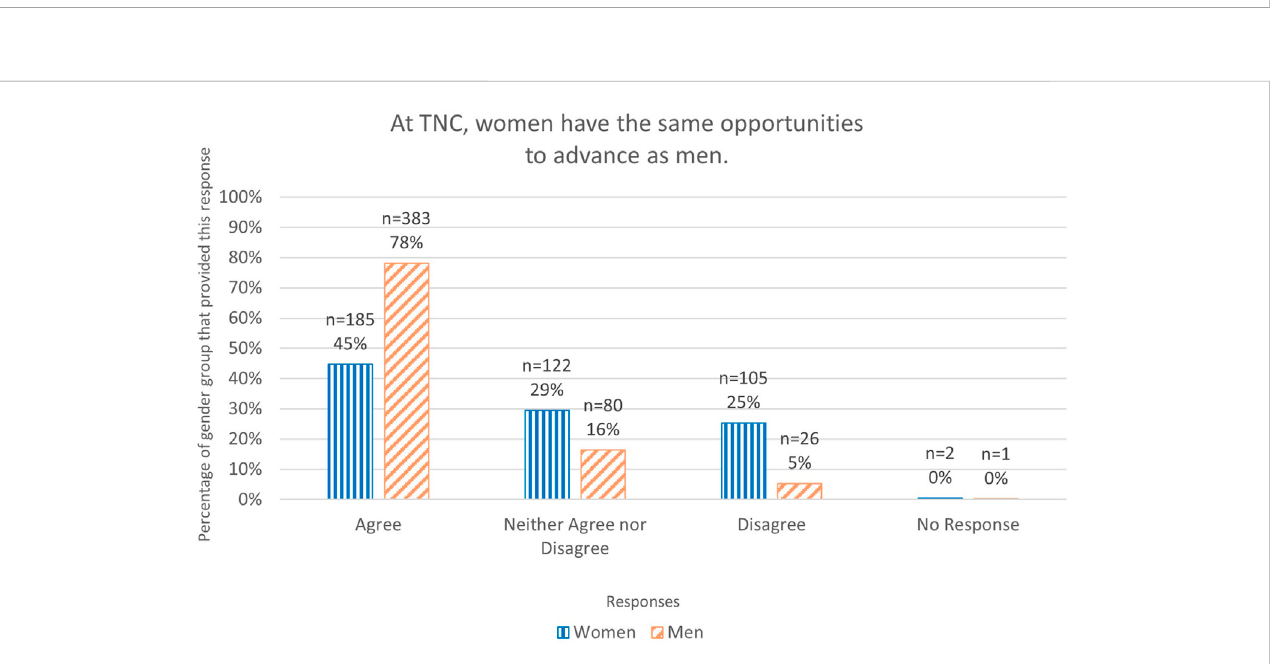
FIGURE 4 Graph of responses to Q17. At TNC, women have the same opportunities to advance as men. As a percentage of the total number of respondents for each